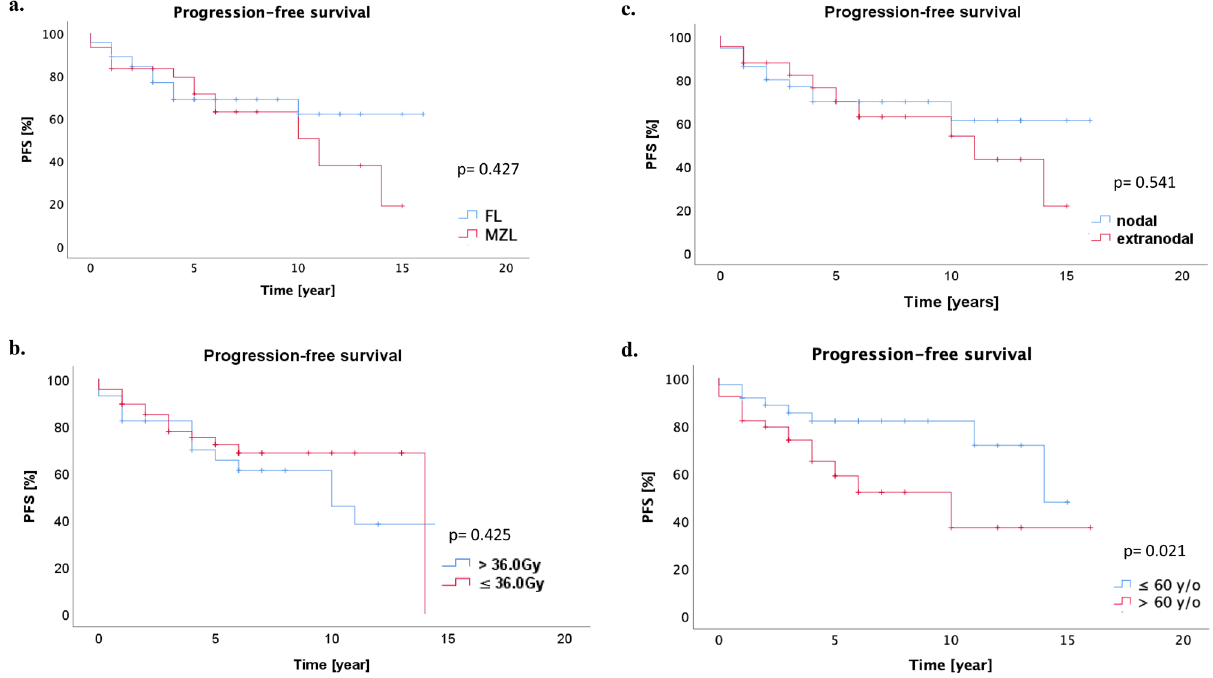
Figure 2. ( a ) Different lymphoma subtypes achieved a comparable long-term outcome (5-year PFS for FL 68.8% vs. MZL 79.4%, p = 0.427). ( b ) Total radiation dose of > 36.0 Gy had no prognostic influence to PFS (5-year PFS 65.5% vs. 72.1% for > 36.0 Gy vs ≤ 36.0 Gy, p = 0.425). ( c ) Extranodal involvement was not associated with inferior PFS (5-year PFS 76.0% vs. 69.6% for extranodal and nodal involvement, p = 0.541). ( d ) Patients who were younger than or equal to 60 y/o had significantly improved PFS compared to patients who were older than 60 y/o (5-year PFS 81.9% and 65.1%, p =